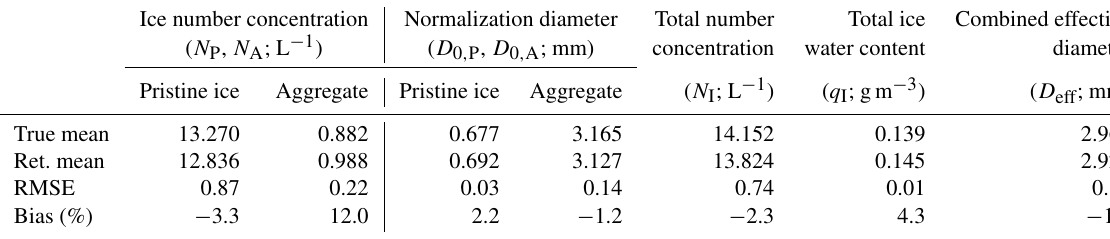
Table 5. Truth means and the means, root-mean-square error (RMSE), and biases in retrieval in the synthetic dataset experiment. Ice number concentration Normalization diameter Total number Total ice Combined effective ( N P , N A ; L − 1 ) ( D 0 , P , D 0 , A ; mm) concentration water content diameter Pristine ice Aggregate Pristine ice Aggregate ( N I ; L − 1 )